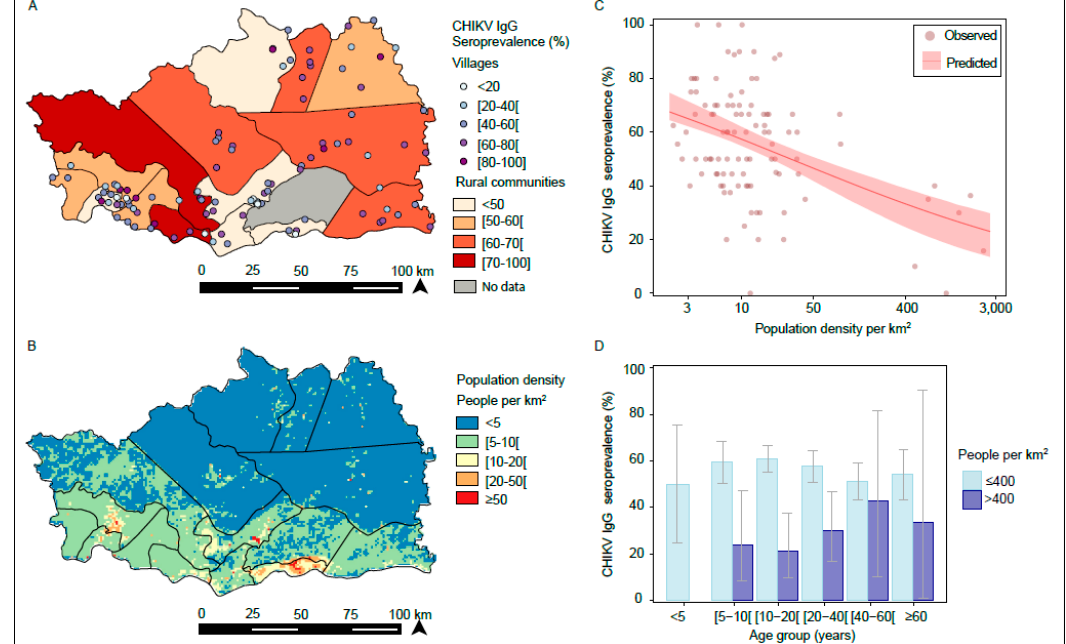
Figure 1. Spatial variation in chikungunya virus (CHIKV) IgG seroprevalence. ( A ) Seroprevalence by village and rural community. ( B ) Spatial variation in population density. ( C ) Observed and predicted seroprevalence by population density. The 95% confidence interval (CI) of the prediction was obtained by bootstrap (2000 iterations). ( D ) Age patterns by population density ( ≤ 400 vs. >400 people per km 2 ).